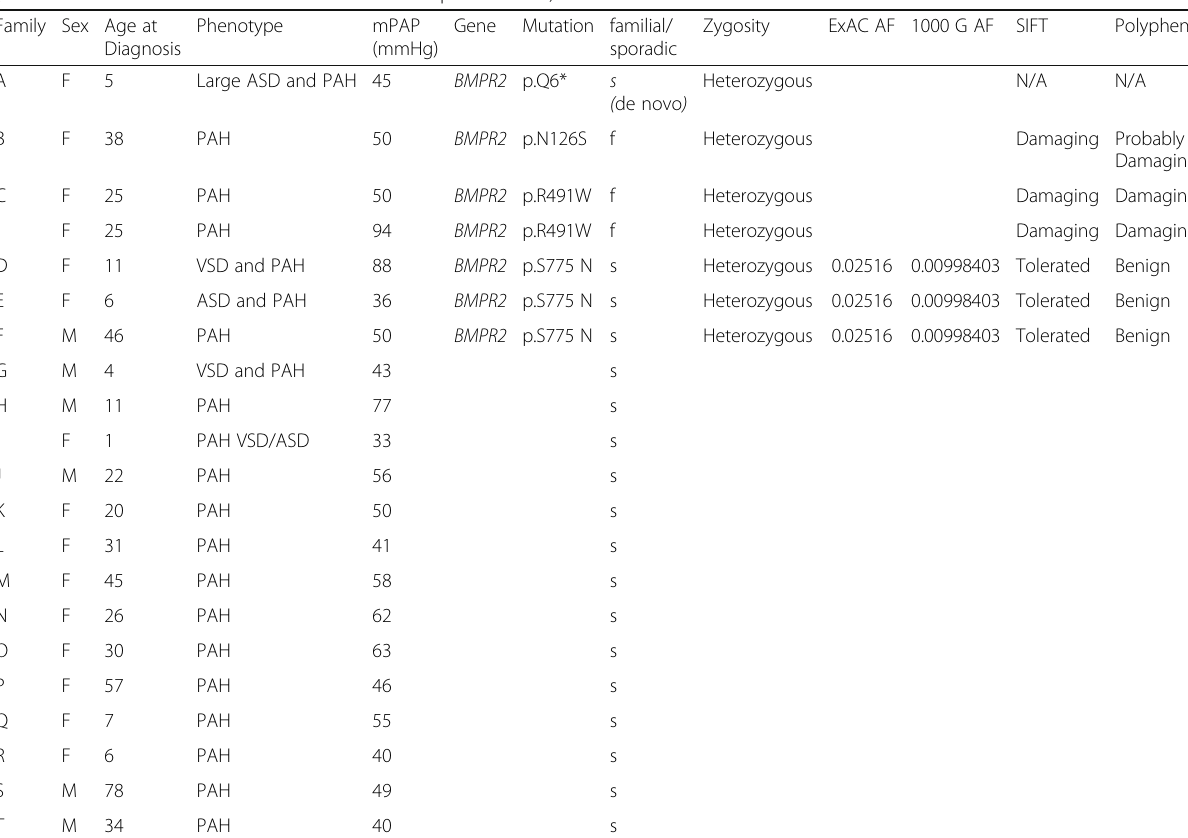
Table 1 BMPR2 variants in pulmonary hypertension patients (PHT), with their corresponding global allele frequencies (AF), and predictive protein effects (Polyphen2). ASD (Atrial Septal Defect), VSD (Ventricular Septal Defect), ExAC (Exome Aggregation Consortium), 1000G (1000 Genome from the International Genome Sample Resource) Family Sex Age at Diagnosis